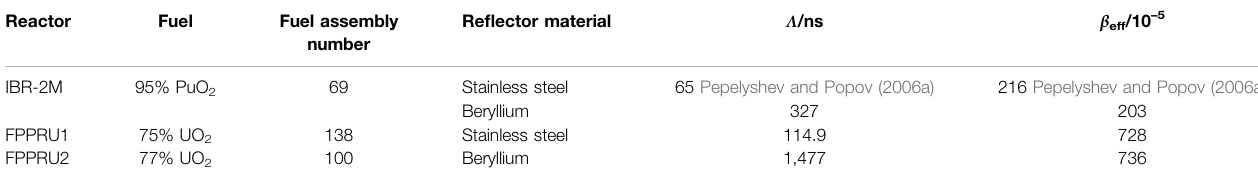
TABLE 1 | Calculating results of the effective delayed neutron fraction β eff and neutron generation time Λ .